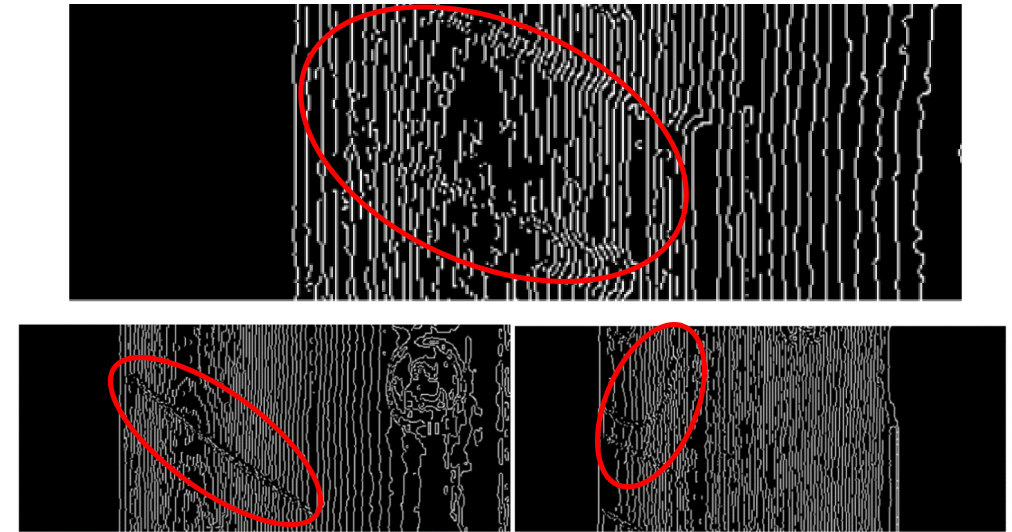
Figure 19. Defect detections in di ff erent images. Red areas indicate the position of defects. ( Above ) Common defect; ( below left ) extended defect; (below right) other defect type with di ff erent